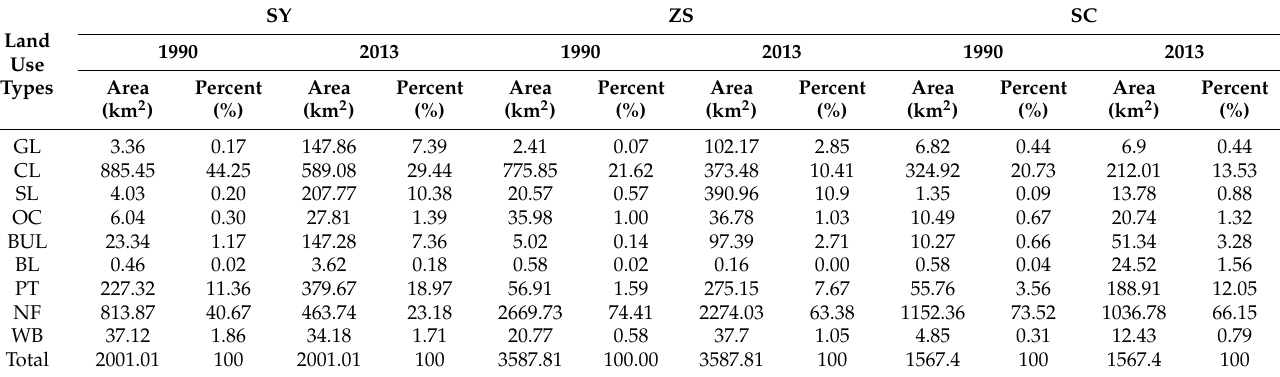
Figure 3. Distribution of land use types in the study area ( a – c ) in 1990, and ( d – f ) in 2013. Table 3. The land use types and proportions in the study areas.